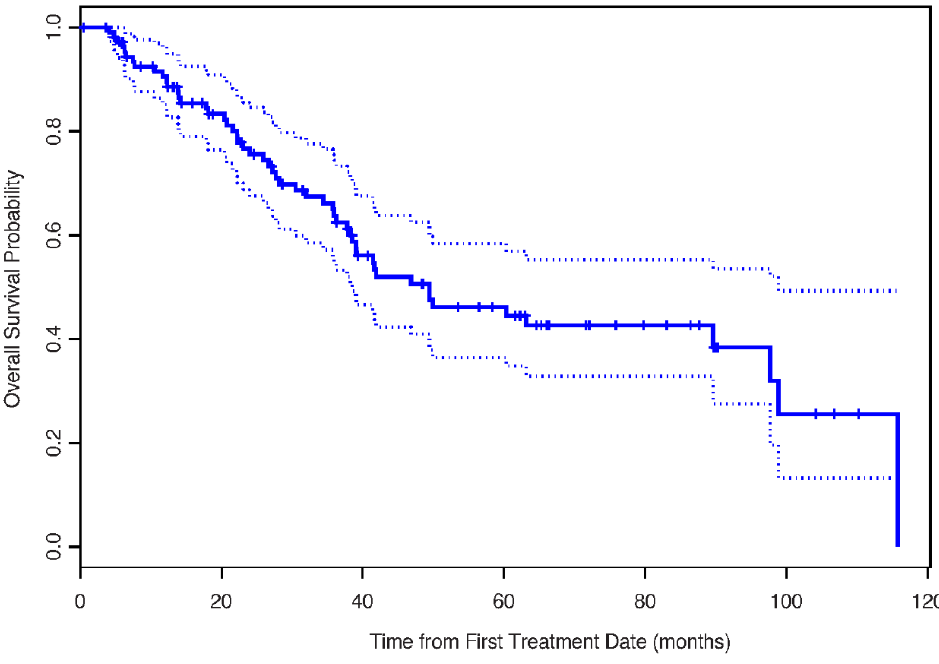
Figure 3. The Kaplan–Meier estimates for overall survival.